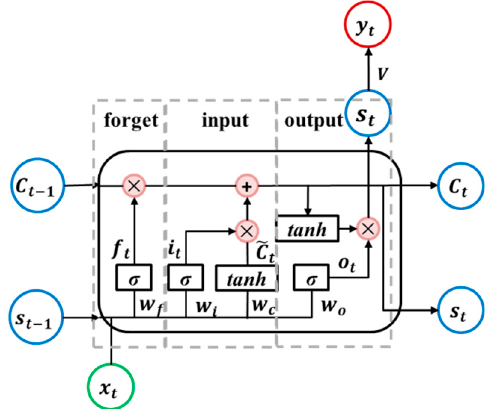
Figure 4. Diagram of the long short-term memory recurrent neural network (LSTM RNN) unit.